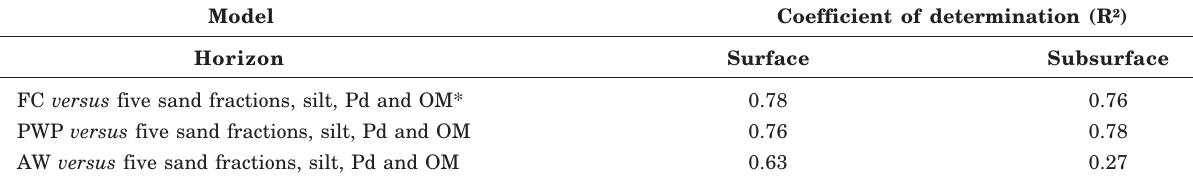
Table 3. Coefficients of determination obtained from multiple linear regressions for prediction of field different soil profiles in the State of Santa Catarina